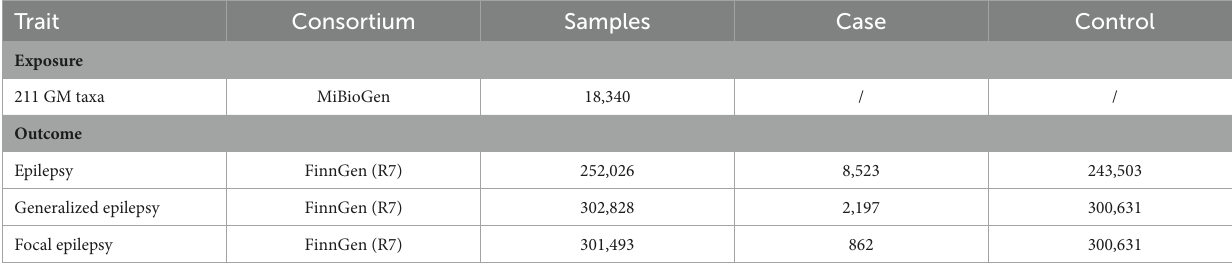
TABLE 1 Details of the exposure and